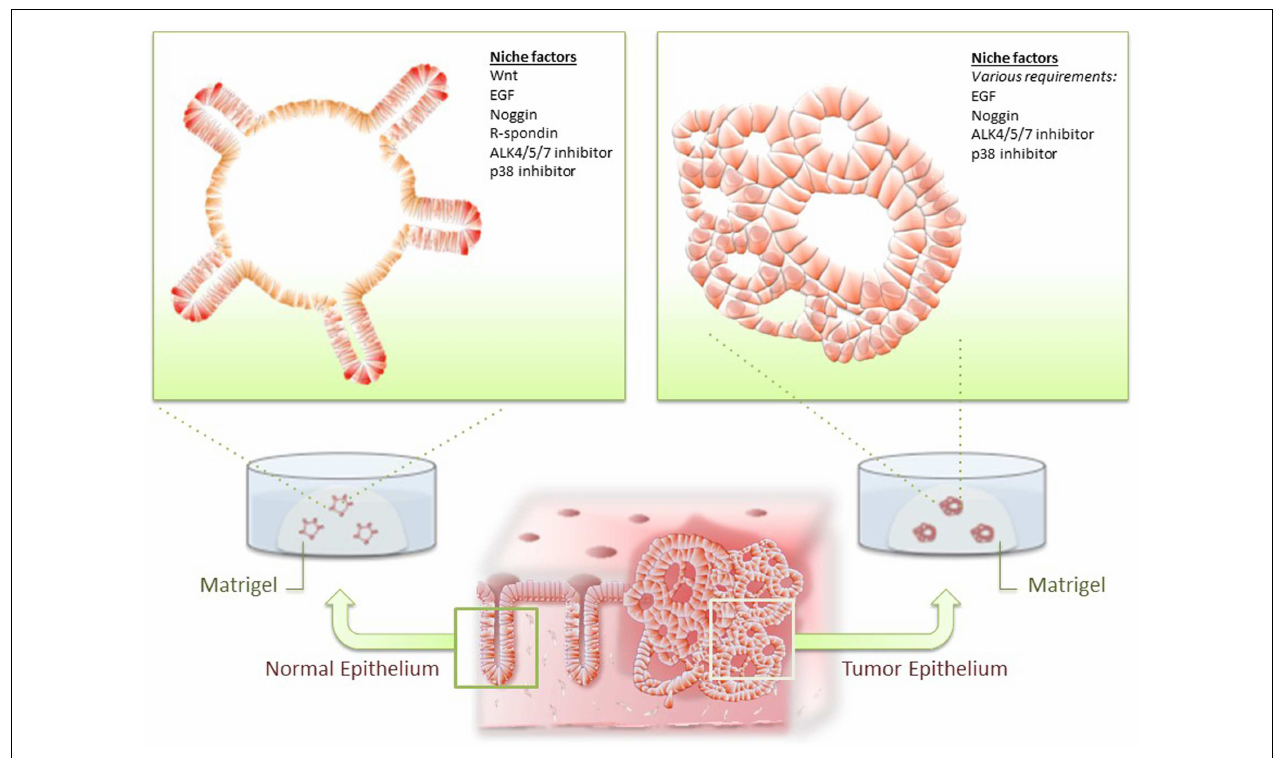
factors. Normal epithelium consistently forms stereotypic organoid structures resembling intestinal crypts, whereas CRC developed dysplastic organoid structures.